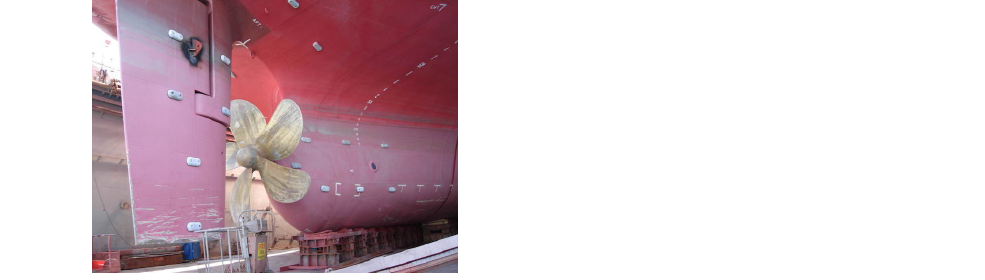
Figure 1. Semi-spade rudder for commercial vessel (marineinsight.com, accessed on 8 June 2018).